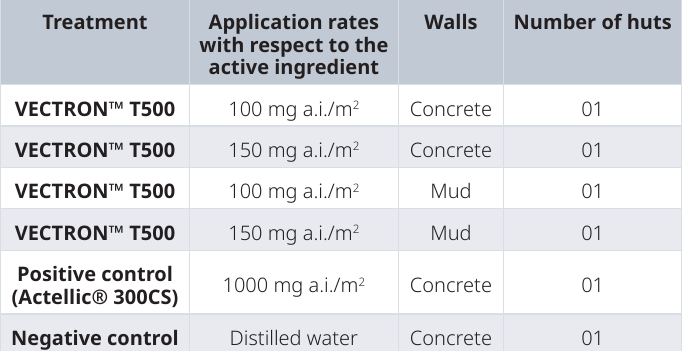
Table 2. Treatments and substrates used for the experimental hut study.